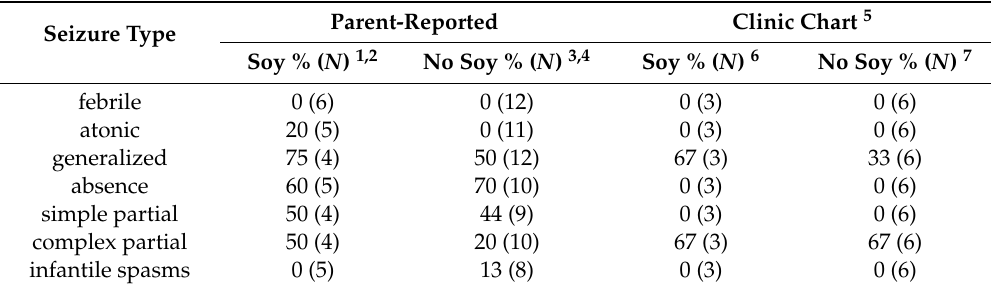
Table 6. Parent versus clinic-reported seizure types in study